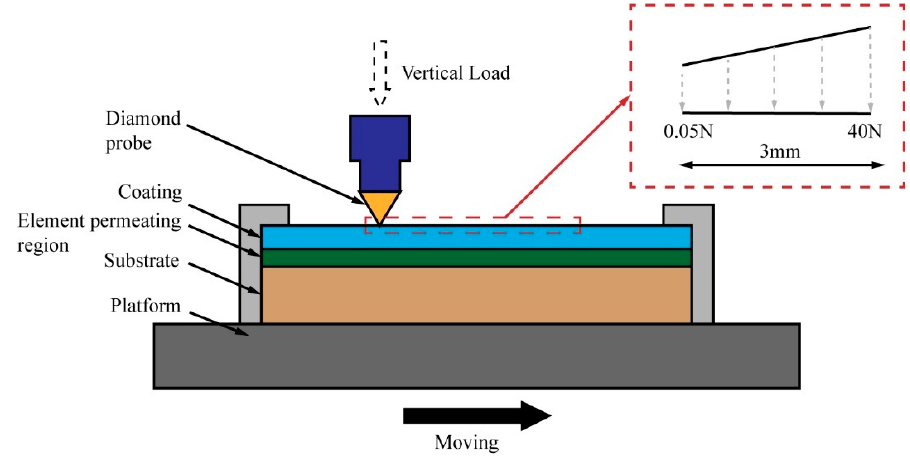
Figure 7. Schematic of the coating adhesion test.